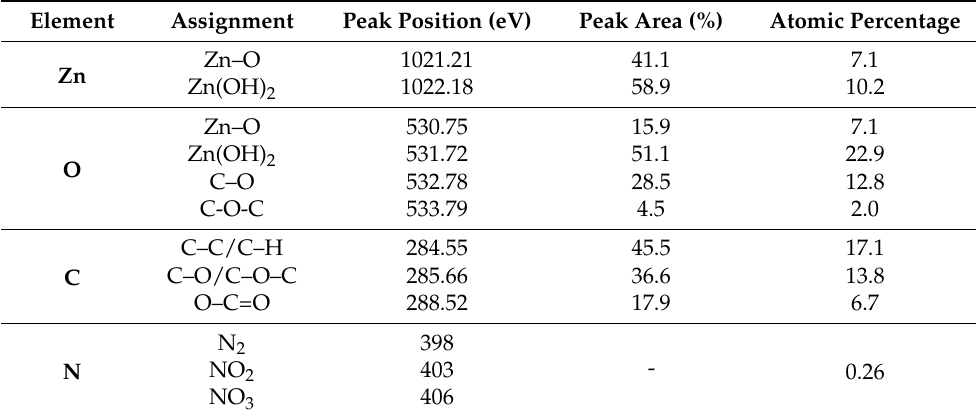
Table 2. Atomic percentage of Zn for the coatings obtained at different deposition parameters. Deposition Scan